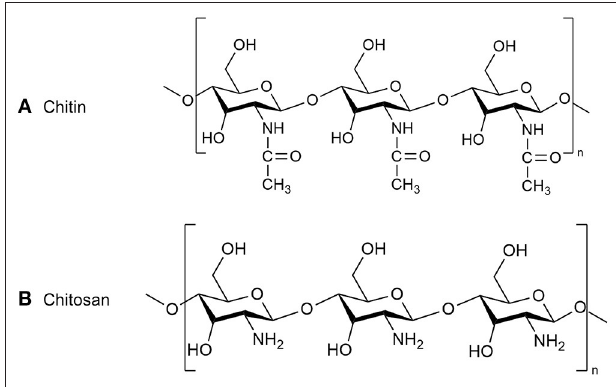
FIGURE 4 | The chemical structure of (A) chitin and (B) chitosan.